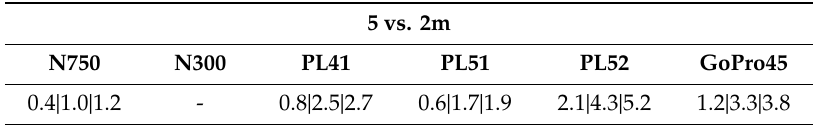
Table 6. Comparison of photogrammetric bundle adjustment (BA) solutions for di ff erent camera nine PRPs + SRPs 3D coordinates (values are in mm).